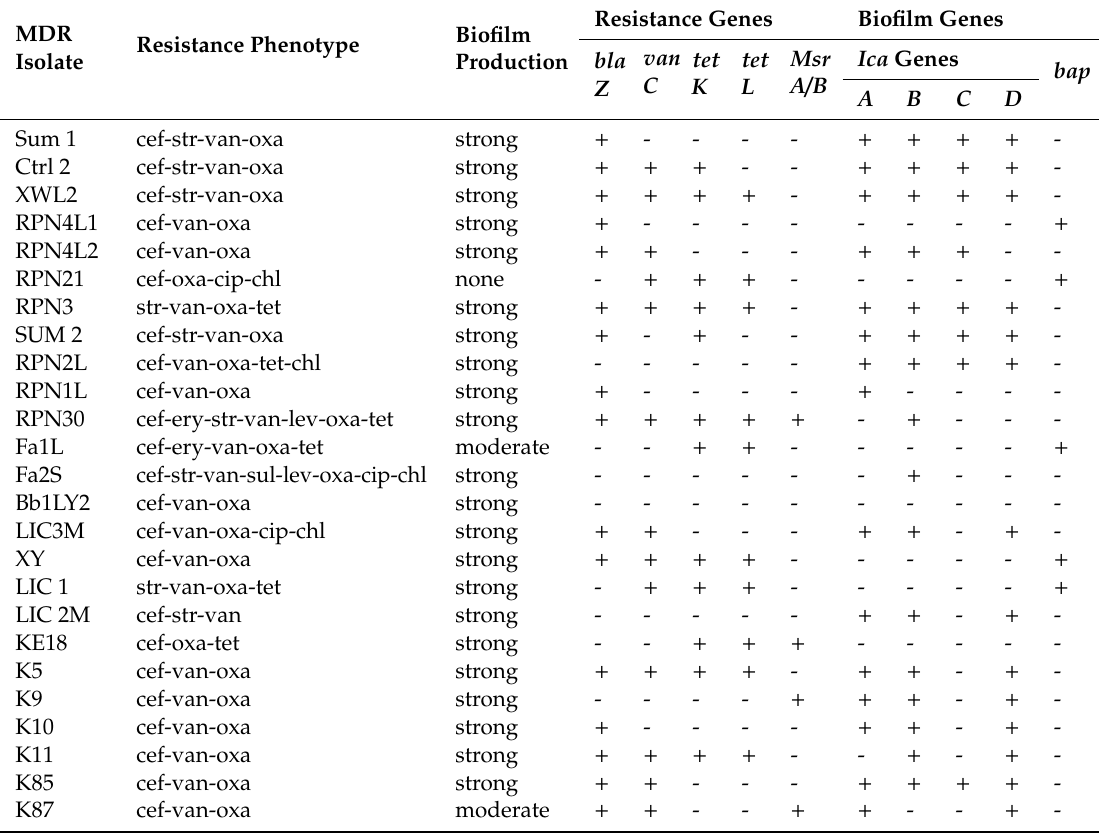
Table 4. Antimicrobial resistance and biofilm profile of MDR S. aureus isolates.